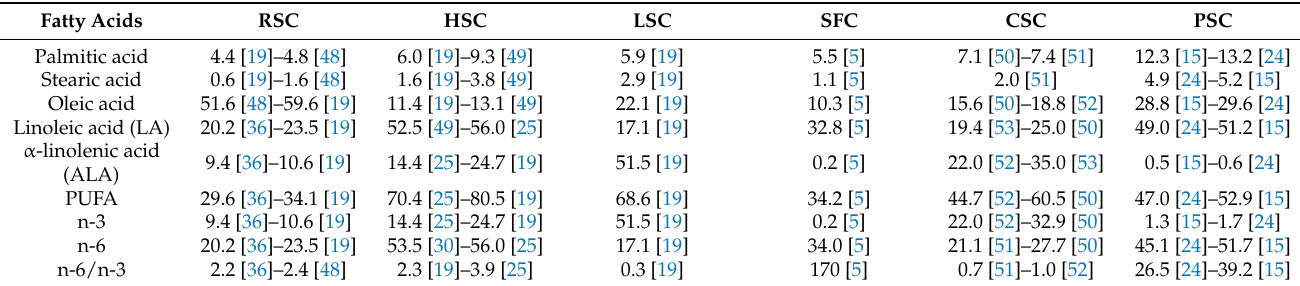
Table 3. Fatty acid (FA) profile of cold-pressed cakes (% of total fatty